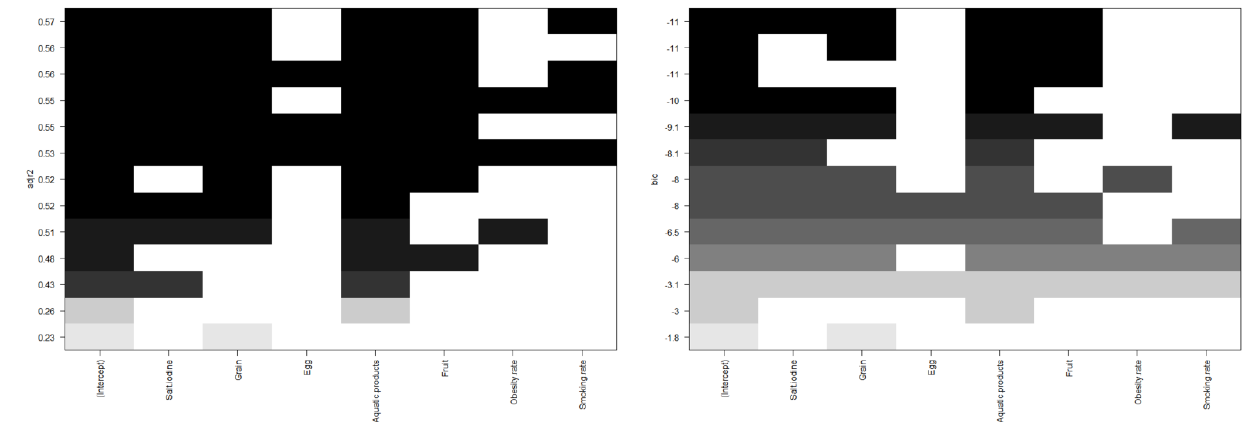
Figure 7. R 2 ( left ) and BIC ( right ) values for models with different dietary behavioral factors. TC (RR = 1.047, 95%CI: 1.020 to 1.075). That was, for every 1kg increase in aquatic prod-